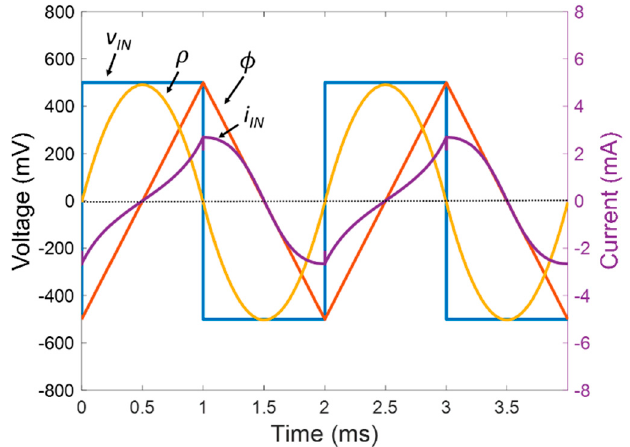
Figure 8. Signals extracted from the simulation results of the continuous-state meminductor using a square input signal with an amplitude peak-to-peak of 1 V and a frequency of 1 kHz.